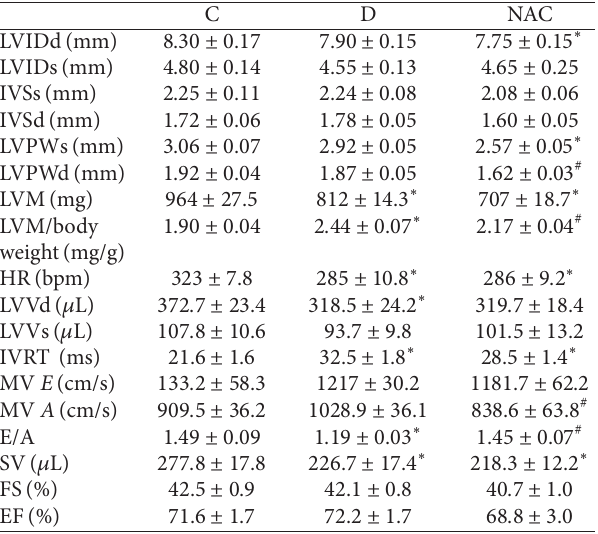
Figure 1: Effects of N-acetylcysteine (NAC) treatment on the level of TNF-alpha (a) and IL-6 (b) in plasma. Control (C) or STZ-induced diabetic rats without treatment (D) or with NAC treatment (1.5g/kg/day, D + NAC) for 4 weeks. All values are expressed as mean ± S.E.M. 𝑛 = 6 per group. ∗ 𝑃 < 0.05 versus C; # 𝑃 < 0.05 versus D. Table 3: M-mode Echocardiographic and transmitral Doppler flow velocity indices of LV dimensions and